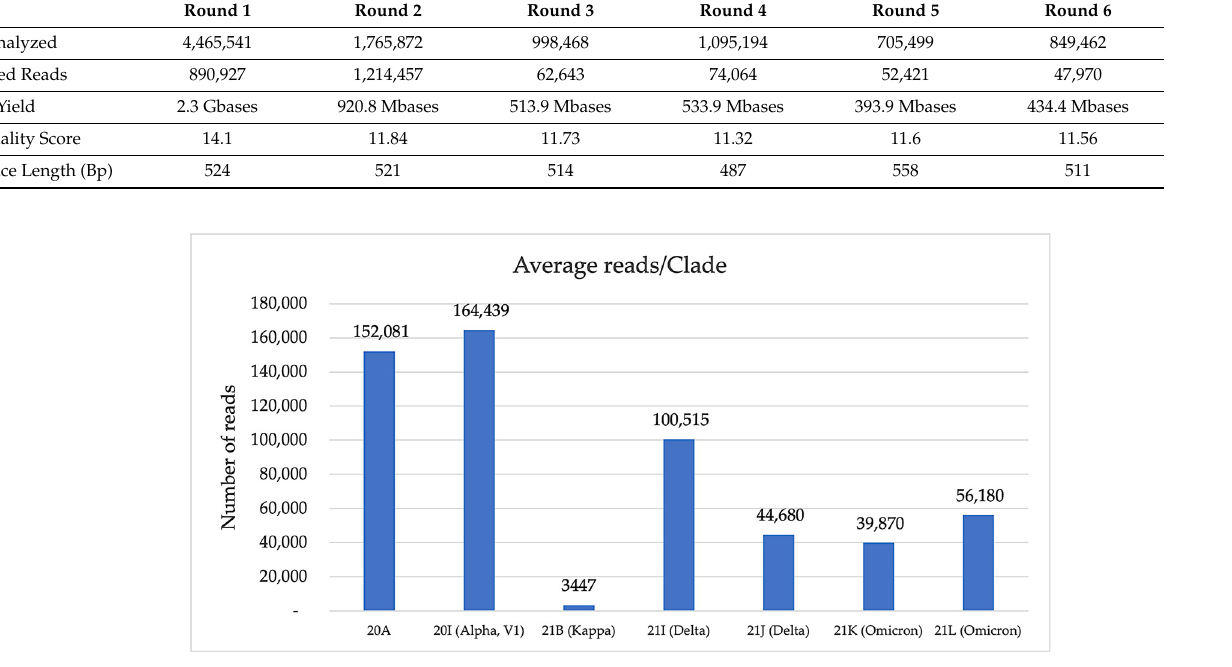
Figure 1. Average read count per each clade.